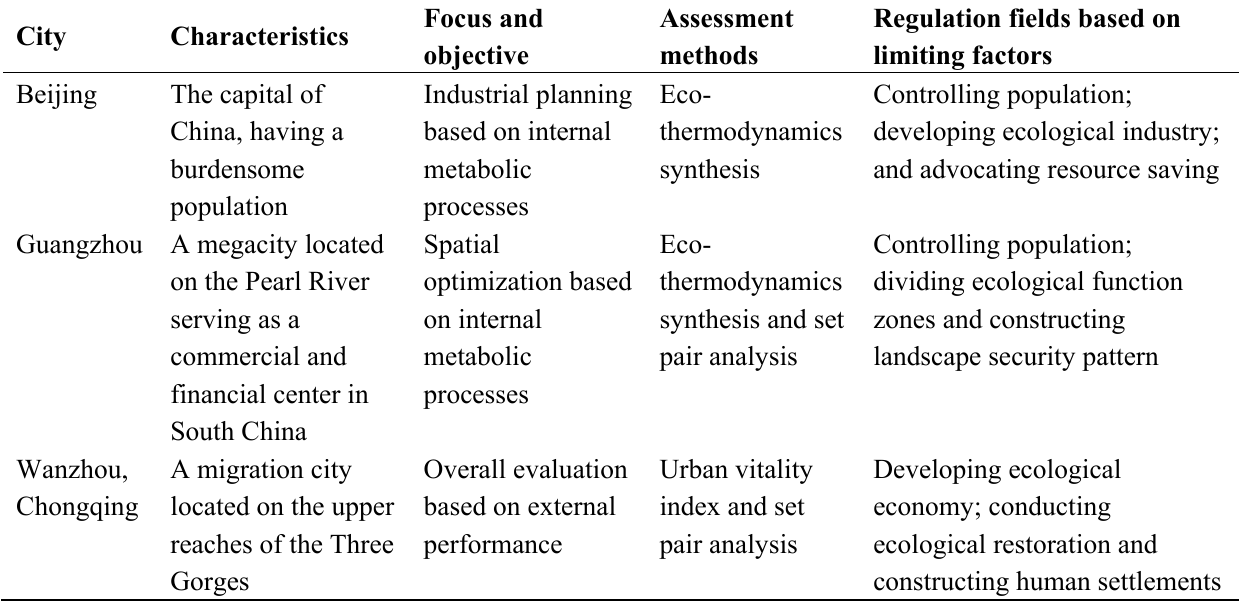
Table 2. Urban ecosystem health assessment in three Chinese